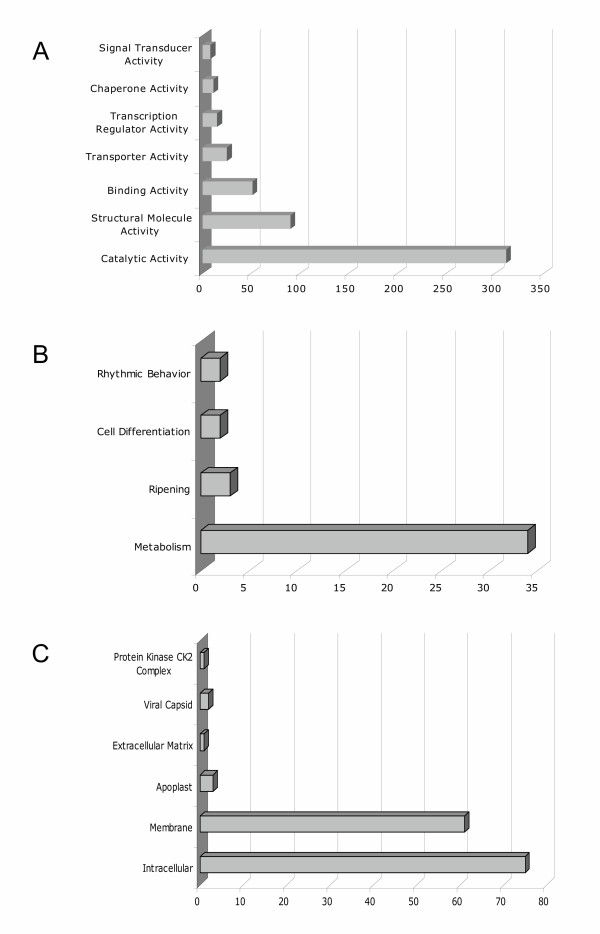
Strawberry EST characterization as derived from GO analyses. ESTs were assigned to GO categories based onA) Functional GO matches B) Process GO matches C) Component GO matches.